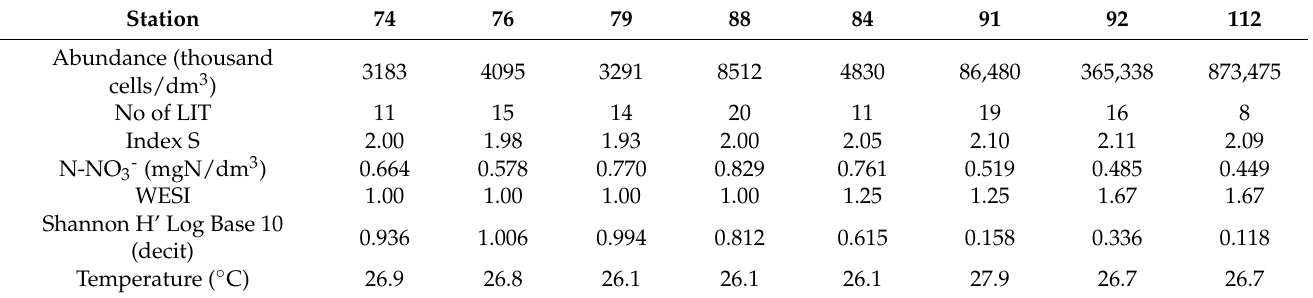
Table 5. Indices of saprobity, Shannon, WESI, LIT richness, abundance, and main indicators of the environment at the stations of the Alexandrovskoye reservoir. The stations are located in the direction of the reservoir axis from the upper to the